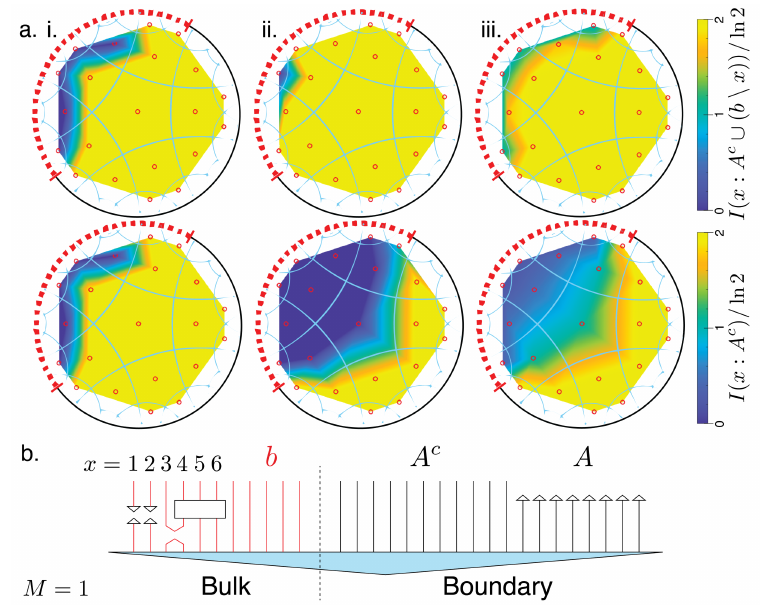
Figure 15 . In the M = 1 HaPPY code, bulk qubits x ∈ b can be uncorrelated with the boundary A c while remaining entangled with other bulk qubits following a LPM on the boundary A .